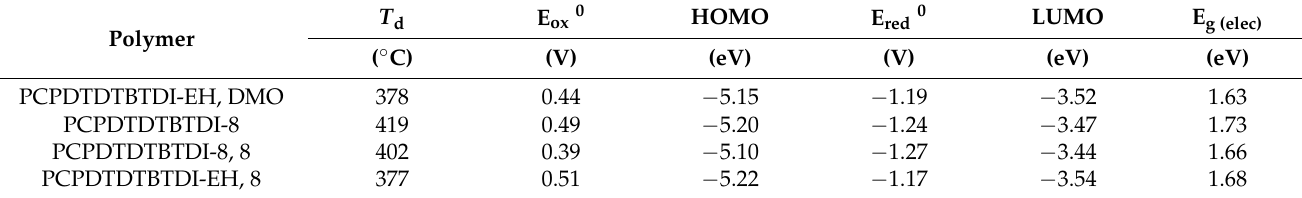
Table 3. Thermal and electrochemical properties of the